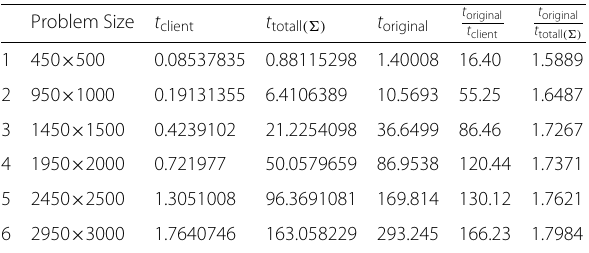
Table 2 Ax ≡ b mod 251 with parameters